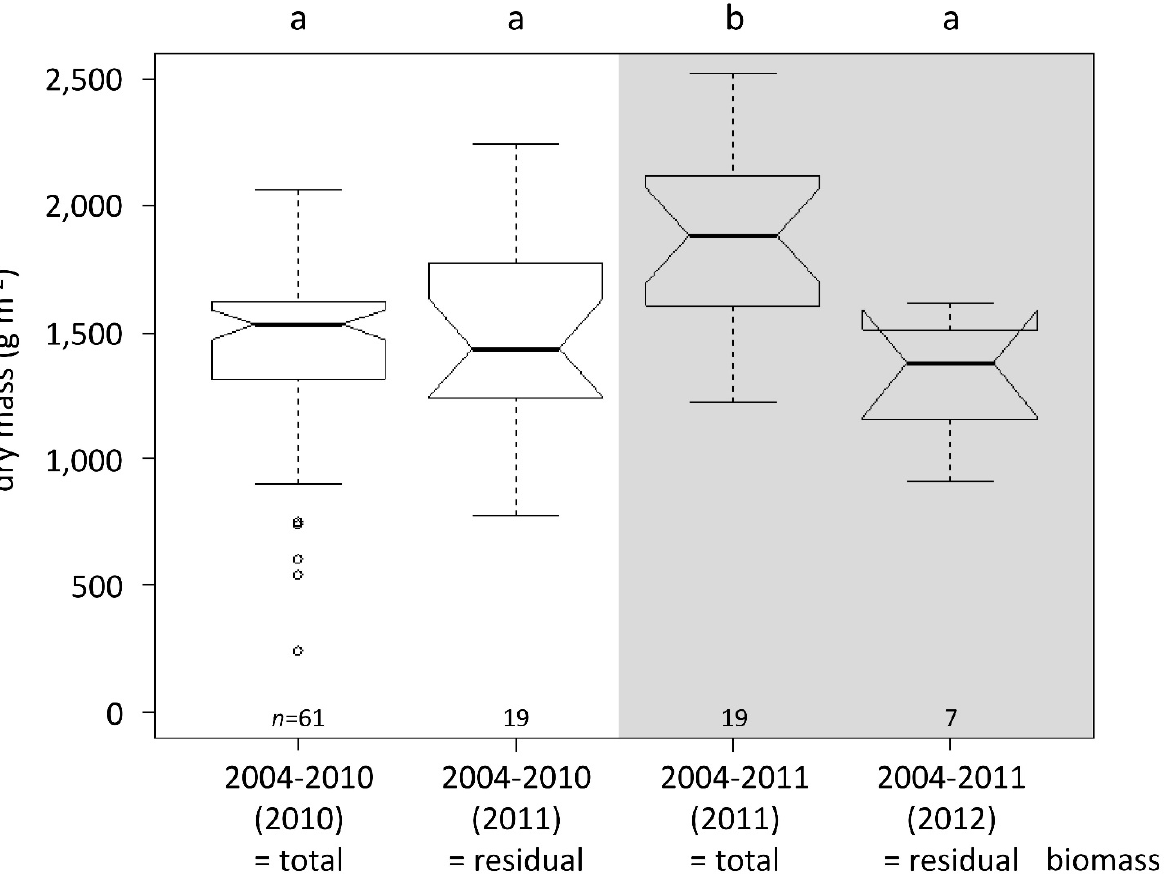
Figure 13. Biomass accumulation of peatmoss for 2004–2010 (white) and 2004–2011 (grey), as determined at the ends of these periods (2010 or 2011 = total biomass) and one year later (2011 or 2012 = residual biomass). Number of samples is written below each boxplot. Values with different letters differ significantly (P ≤ 0.05). Differences were analysed using the non-parametric Kruskal Wallis test after Siegel & Castellan